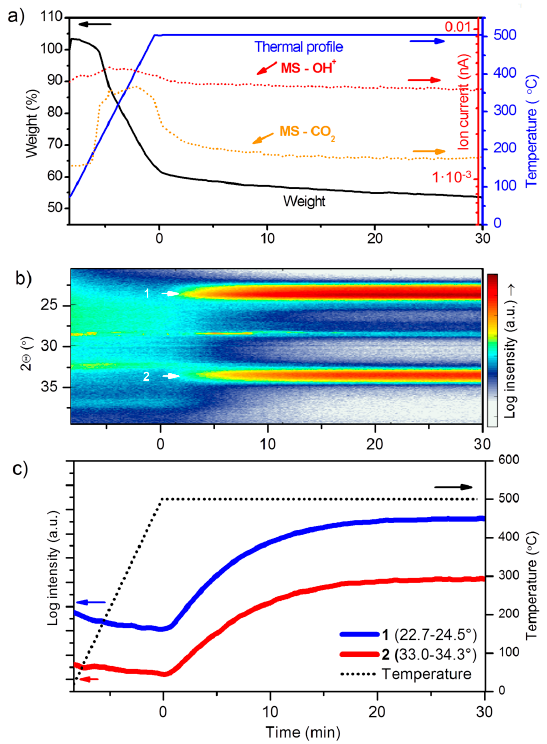
Figure 7. Analysis of as-deposited W-precursor films on: ( a ) glass showing TGA coupled with MS (10 ◦ C · min − 1 in static air, m / z 17/OH and 44/CO 2 ) and isXRD on coated TiN/Si micro-cylinders showing: ( b ) peak intensity as function of peak position and time; and ( c ) integrated peak intensities of specified diffraction peaks as function of temperature, where blue is related to peak 1 and red to peak 2 to in ( b